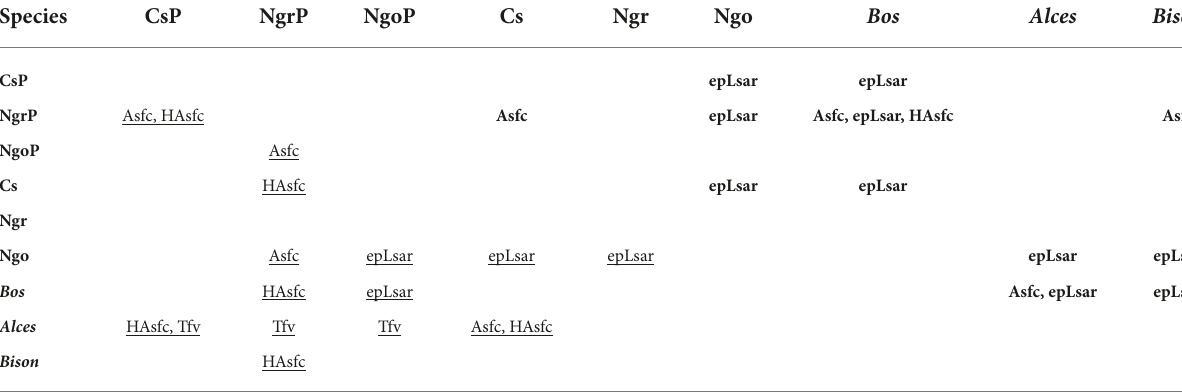
TABLE 5 Post-hoc test and pairwise multiple comparisons between caprines and reference species. Species CsP NgrP NgoP Cs Ngr Ngo Bos Alces Bison